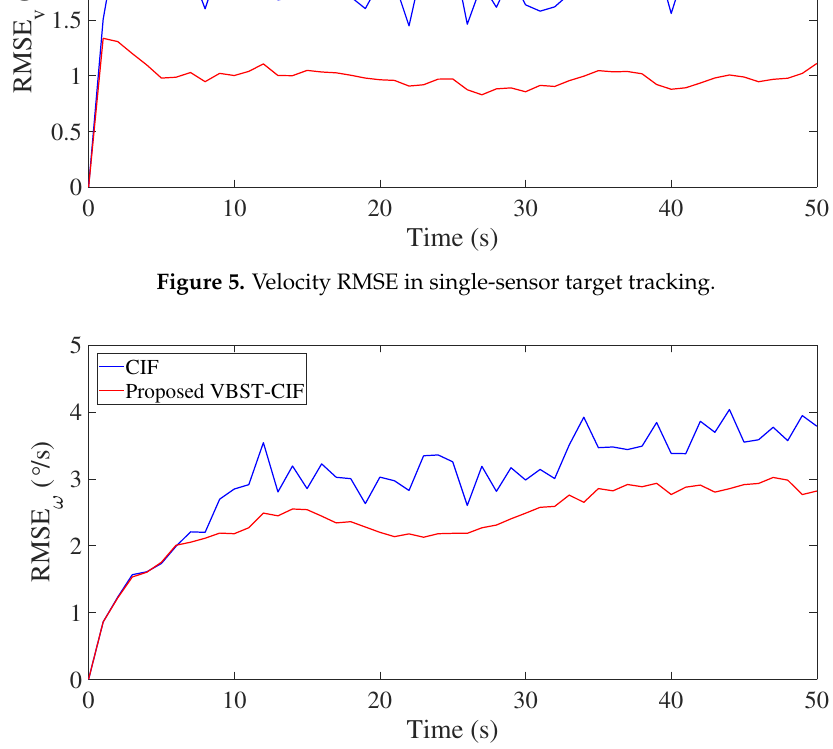
Figure 6. Turning-rate RMSE in single-sensor target tracking. Table 1. Mean-root-mean-square-error (MRMSE) in single-sensor target